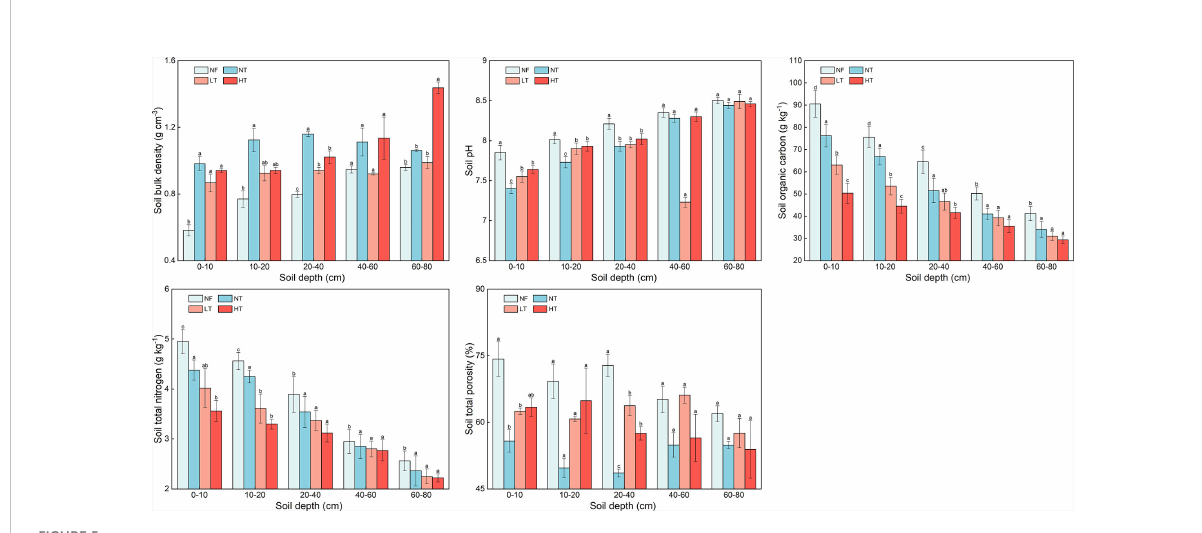
FIGURE 5 Comparison of soil bulk density (BD), pH, soil organic carbon (SOC), soil total nitrogen (TN), and soil total porosity (TP) among different management practices and soil layers. Different lowercase letters above the column indicate signi fi cant differences among the thinning treatments at the same soil depth (P <